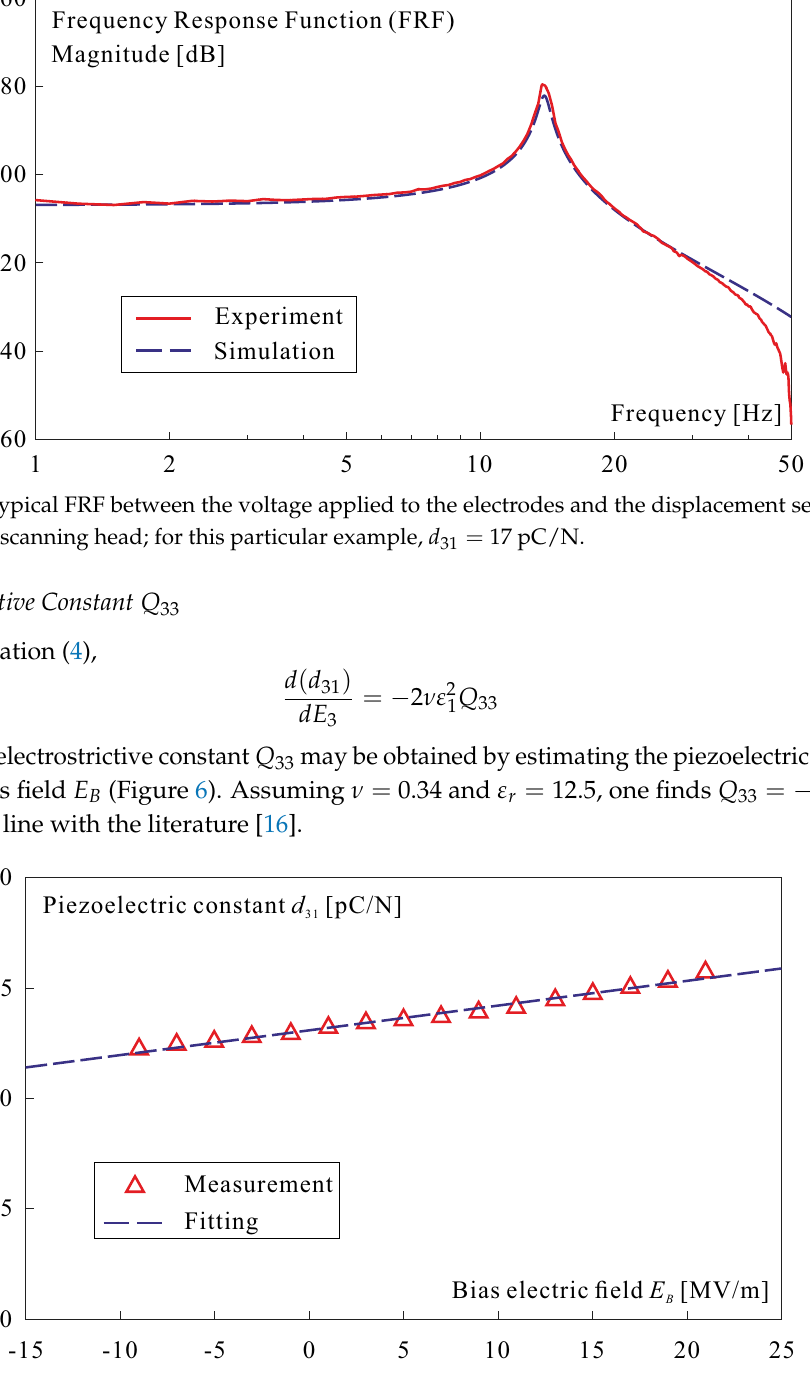
Figure 6. Piezoelectric coefficient d 31 versus bias voltage E B . The slope is related to the electrostrictive constant Q 33 according to Equation